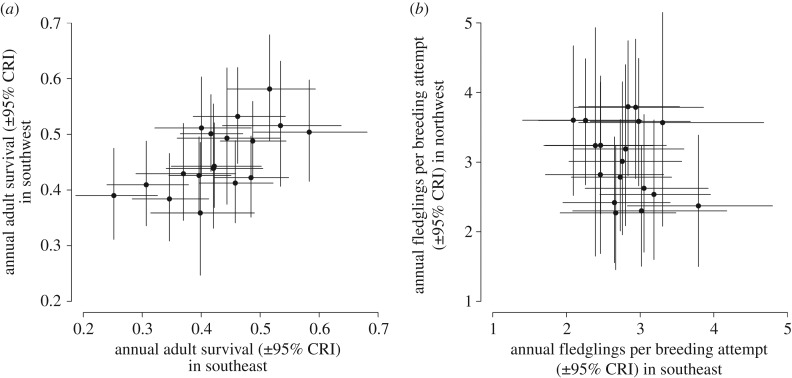
Regional associations between (a) annual adult survival rates (mean (over the posterior samples) correlation coefficient = 0.48 (0.22, 0.69 CRIs), probability of positive correlation = 0.99) and (b) annual productivity (fledglings per breeding attempt; mean (over the posterior samples) correlation coefficient = −0.17 (−0.50, 0.21), probability of positive correlation = 0.23) in the northwest and the southeast of Britain.